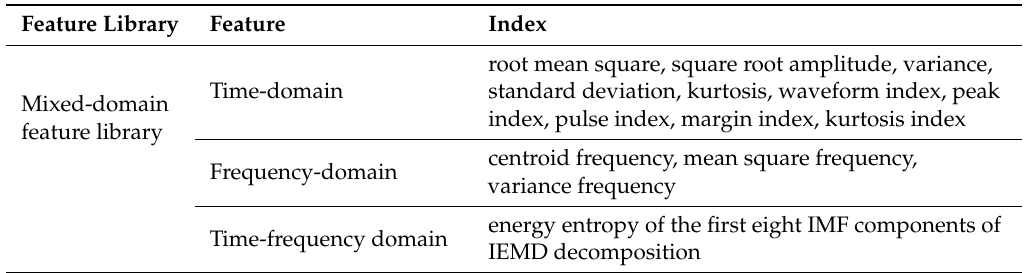
Table 1. Mixed-domain feature library.